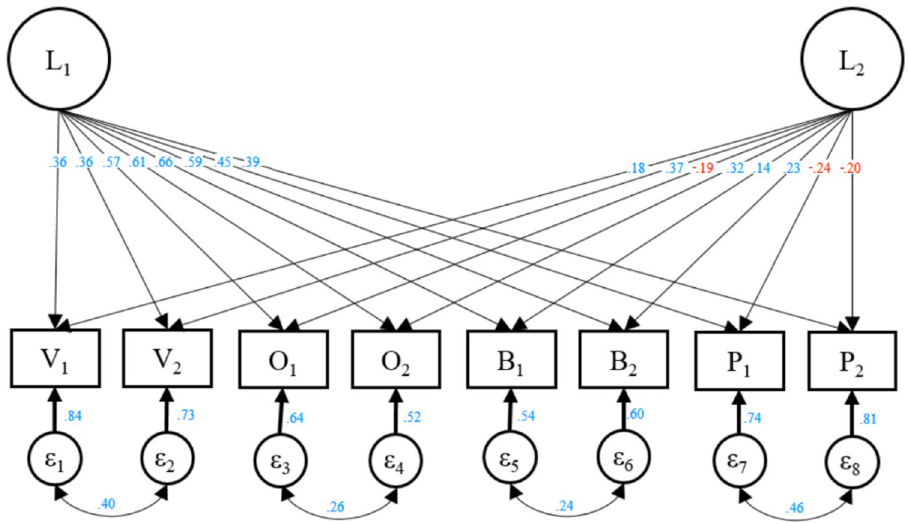
Figure 3. Best fitting model from phenotypic CFA. Illustration of our best fitting model from phenotypic CFA. Blue numbers are positive and red numbers are